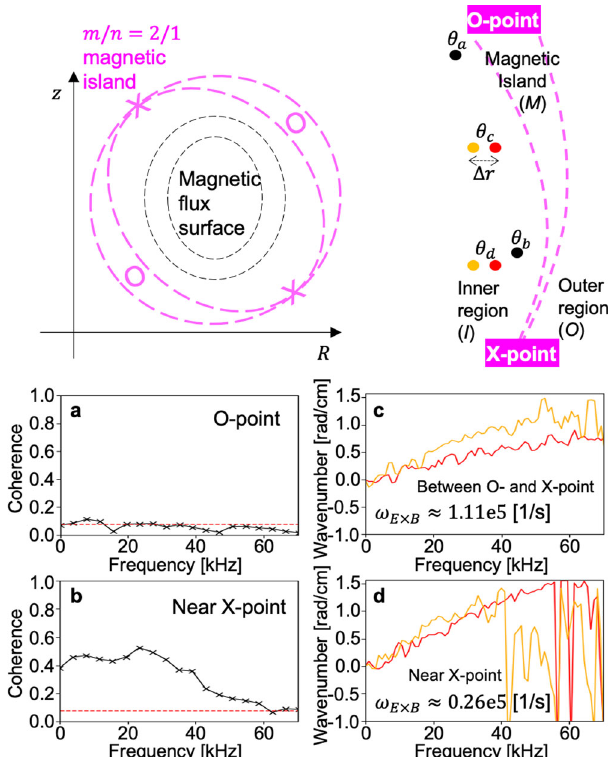
Fig. 1 Inhomogeneous turbulence and fl ow around a magnetic island. a – d The coherence ( a , b ) and local dispersion relations ( c , d ) of the low- k T e turbulence measured at lines in ( c ) or ( d ) represent the two radial measurements at orange and red circles shown in the illustration,